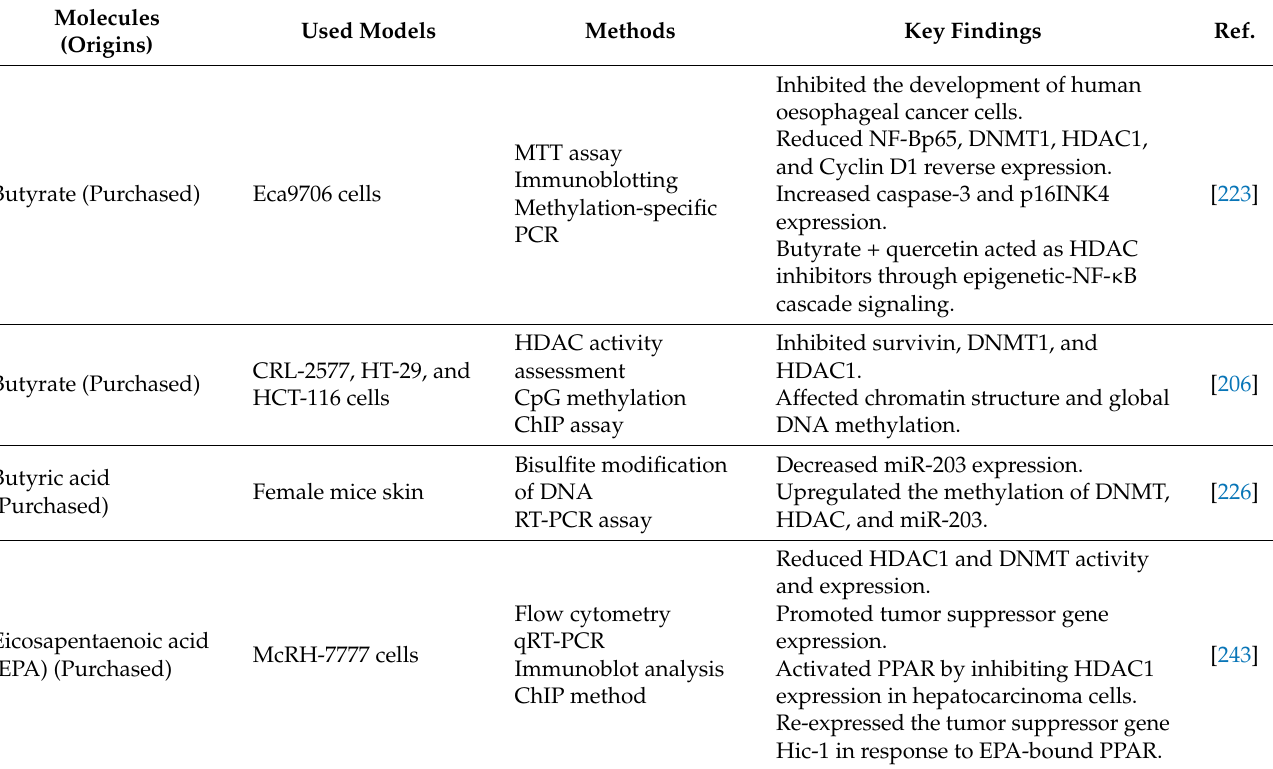
Table 4. Natural fatty acids targeting HDAC in human